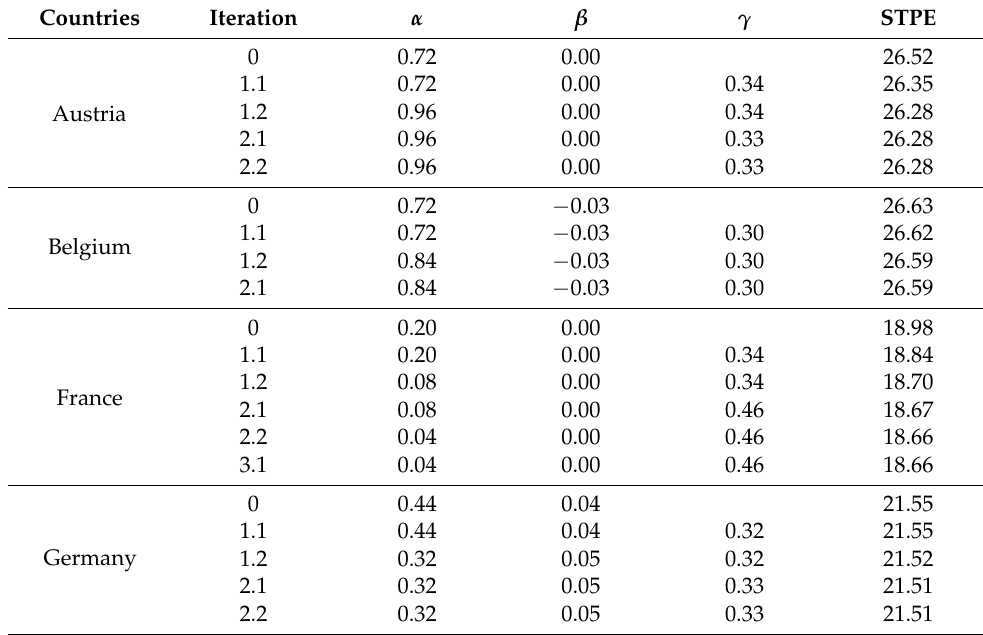
Table A2. Extended 2D- LQ : parameter values in each iteration process. Multiplier